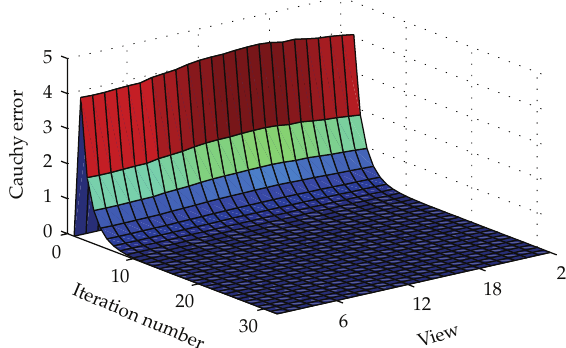
Figure 12: Cauchy error for 24 views and 30 × 30 pixels view.